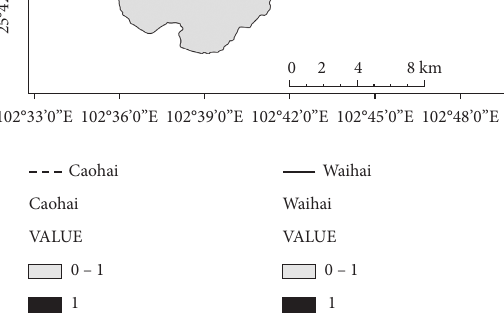
Figure 8: Spatial distribution of water quality in Dianchi based on NDVI